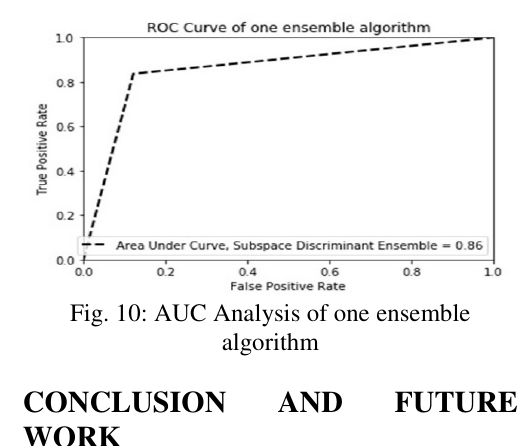
Fig. 10: AUC Analysis of one ensemble